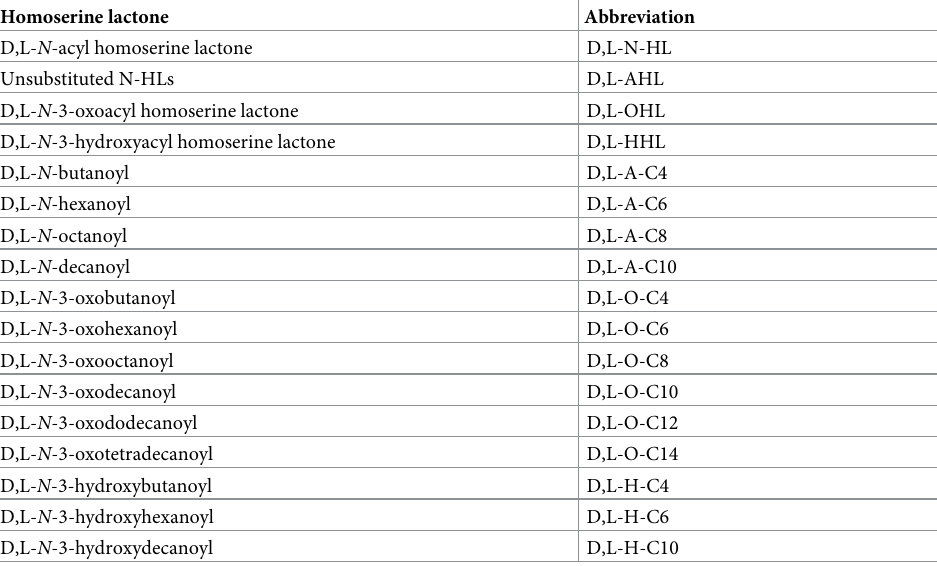
Table 1. Abbreviations of N -acyl homoserine lactones used in this study. Homoserine